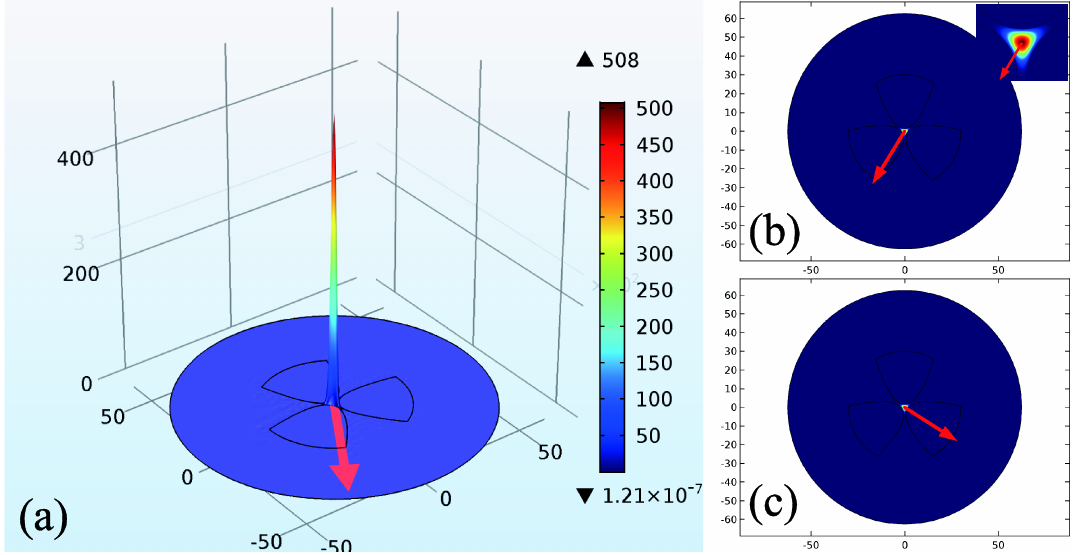
Figure 3. Simulated 3D plot of fundamental mode (FM) ( a ) and intensity profile of ( b ) LP 01-x and ( c ) LP 01-y ( d = 3 µm , a = 0.10 µm −1 , λ = 0.6 µm).